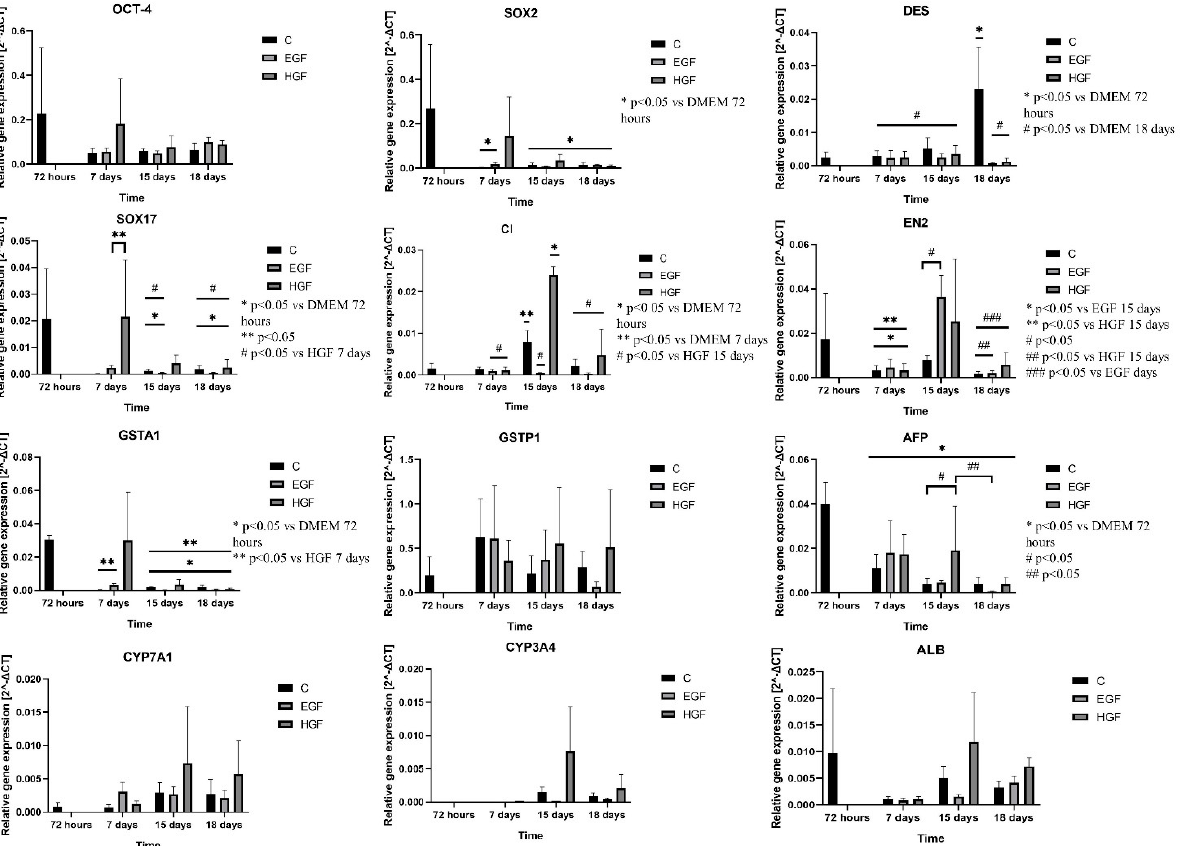
Figure 4. Expression of marker genes of pluripotency: OCT-4 and SOX2 ; endoderm: SOX17 ; ectoderm: EN2 ; mesoderm: DES ; haematopoietic cells: CD45 . Genes of endoderm-derived cell lineages— AFP , ALB , GSTA1 , GSTP1 , CYP3A4 , and CYP7A1— in the control group and in test groups assessed by the RT-PCR method. C—control; EGF and HGF—test groups; n = 3.